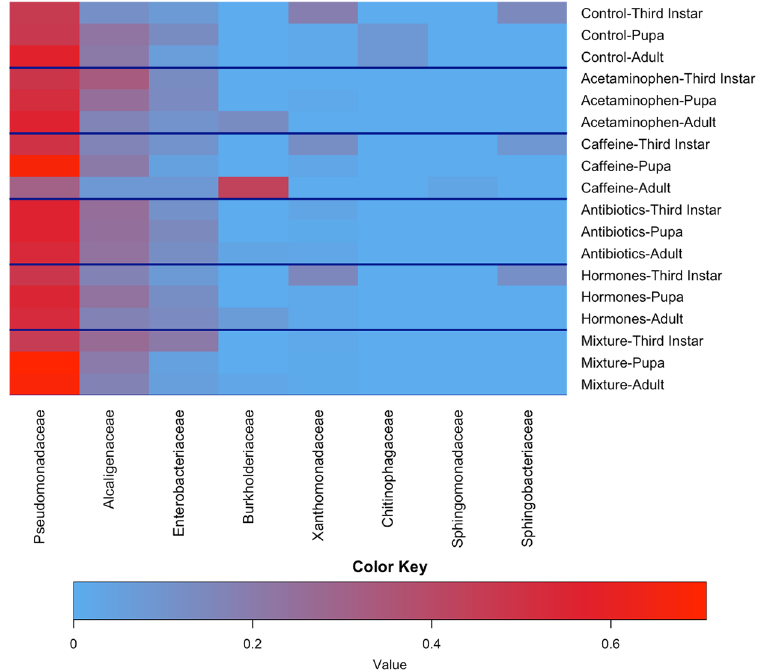
Figure 4. Heatmap of the most abundant bacterial families (each accounting for at least 2.5% of the total OTUs) by average OTUs of treatment life-stage pairing Increased red coloration is an increase in indicative of increased proportional abundance.